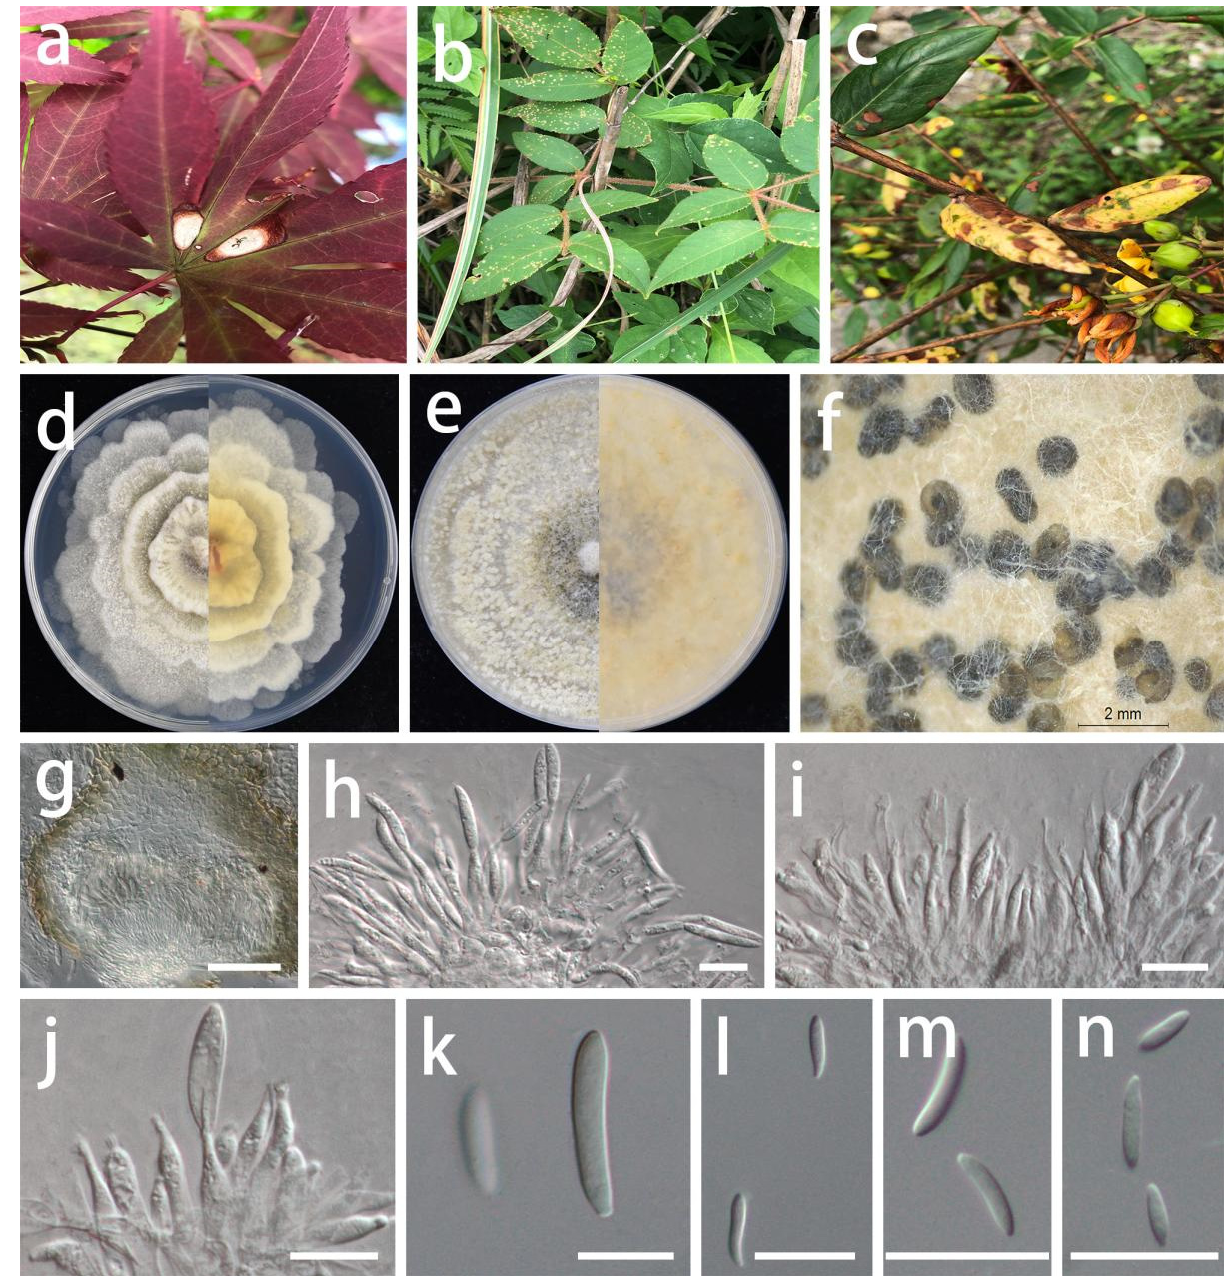
Figure 13. Coniella quercicola (GUCC 412.3). Hosts. ( a ) Acer palmatum ; ( b ) Aralia chinensis ; ( c ) Hypericum patulum . ( d ) Colony on PDA after 2 wk 25 ◦ C (left: above, right: reverse). ( e ) Colony on OA after 2 wk 25 ◦ C (left: above, right: reverse). ( f ) Mass of conidia. ( g ) Conidioma. ( h – j ) Conidiogenous cells. ( k – n ) Conidia. Scale bars: ( g ) = 50 µ m; ( h – n ) = 10 µ